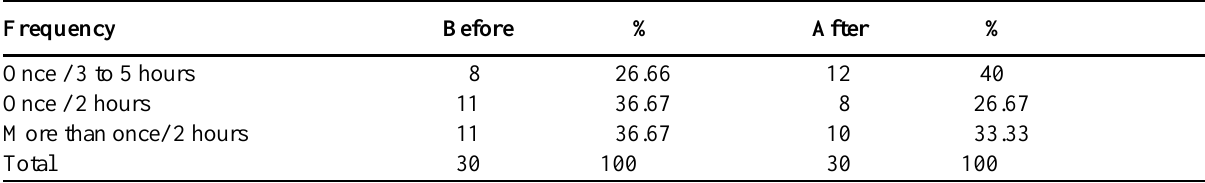
Table 1 – Resiniferatoxin effect on urinary frequency.